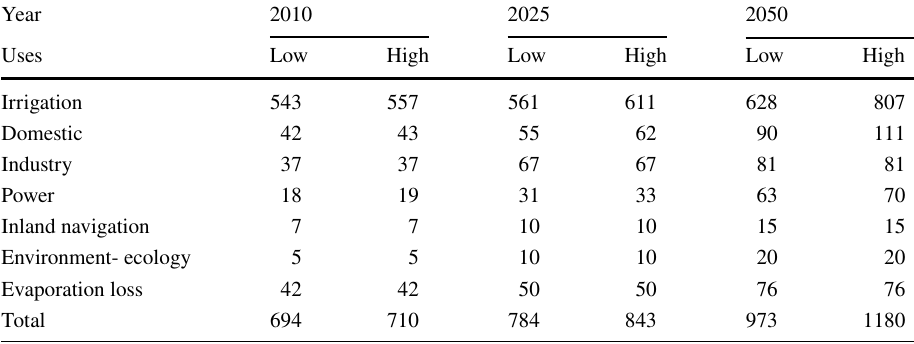
requirement (in km 3 ) for different uses in 2010, 2025, and 2050 in India for low and high population growth scenarios (Jain 2011; Panwar and Chakrapani